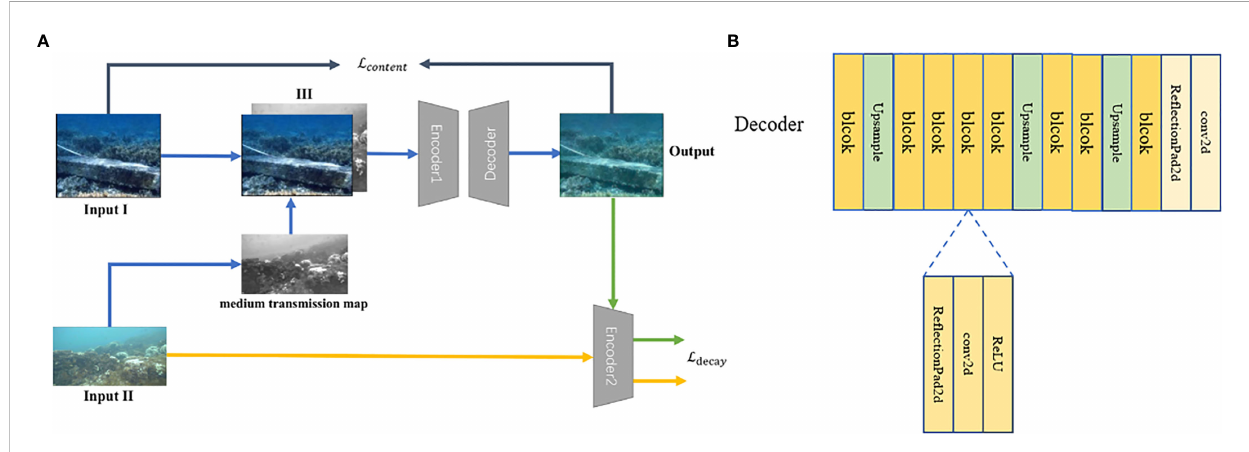
FIGURE 2 The framework of the UDFM. (A) the overall framework the underwater datasets fi tting newtork; (B) the structure of the